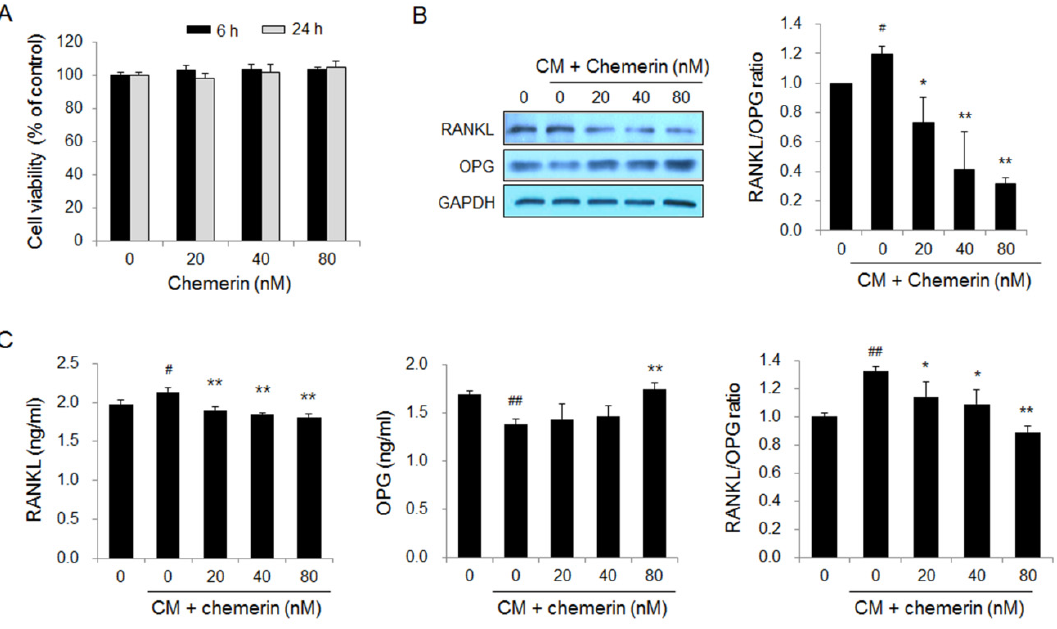
Figure 4. Chemerin suppressed breast cancer cell-induced increase in the RANKL/OPG ratio in osteoblastic cells. ( A ) The viability of hFOB1.19 osteoblastic cells treated with chemerin for 6 and 24 h; ( B ) Protein expression and ( C ) secretion levels of RANKL and OPG in hFOB1.10 osteoblastic cells treated with chemerin in the presence of the conditioned medium (CM) of MDA-MB-231 cells for 6 h and 24 h, respectively. The expression and secretion levels of RANKL and OPG proteins were detected by Western blotting and ELISA, respectively. # p < 0.05, ## p < 0.01 versus cells without CM and chemerin, * p < 0.05, ** p < 0.01 versus cells treated with CM